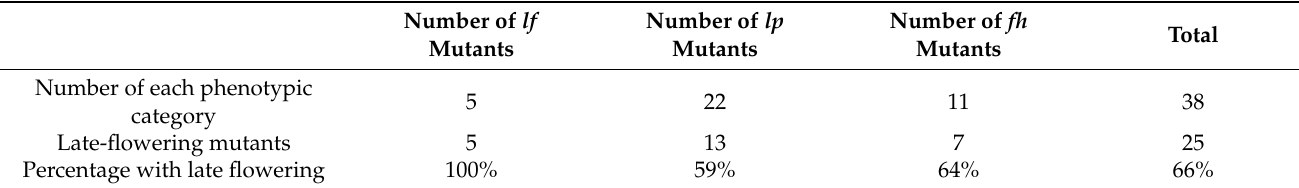
Table 1. Flowering time is associated with three phenotypic groups categorized with late-flowering, large plant, and floral homeotic